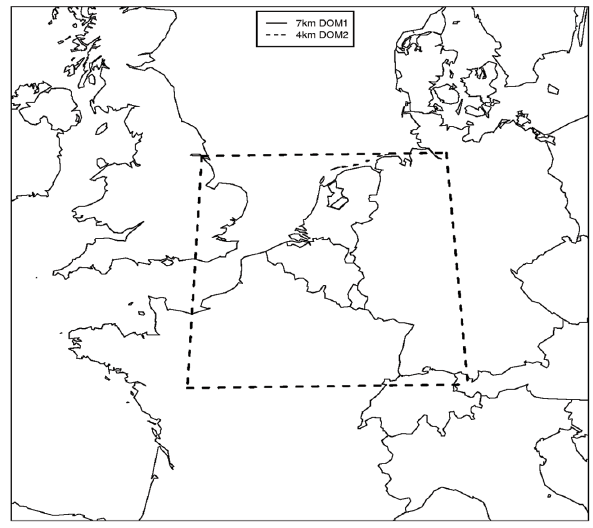
Fig. 1. Domains corresponding to the 7km (border of the panel) and 4km (dashed lines) operational applications.